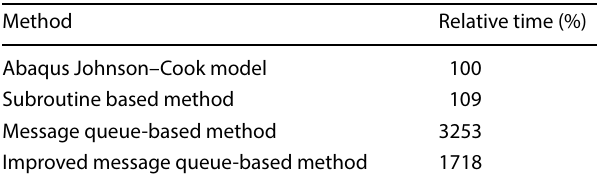
Table 1 Total computational times of FE compression test obtained from three investigated test